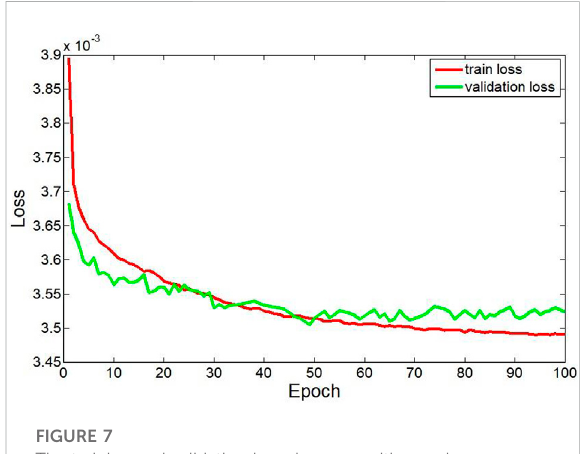
FIGURE 7 The training and validation loss decrease with